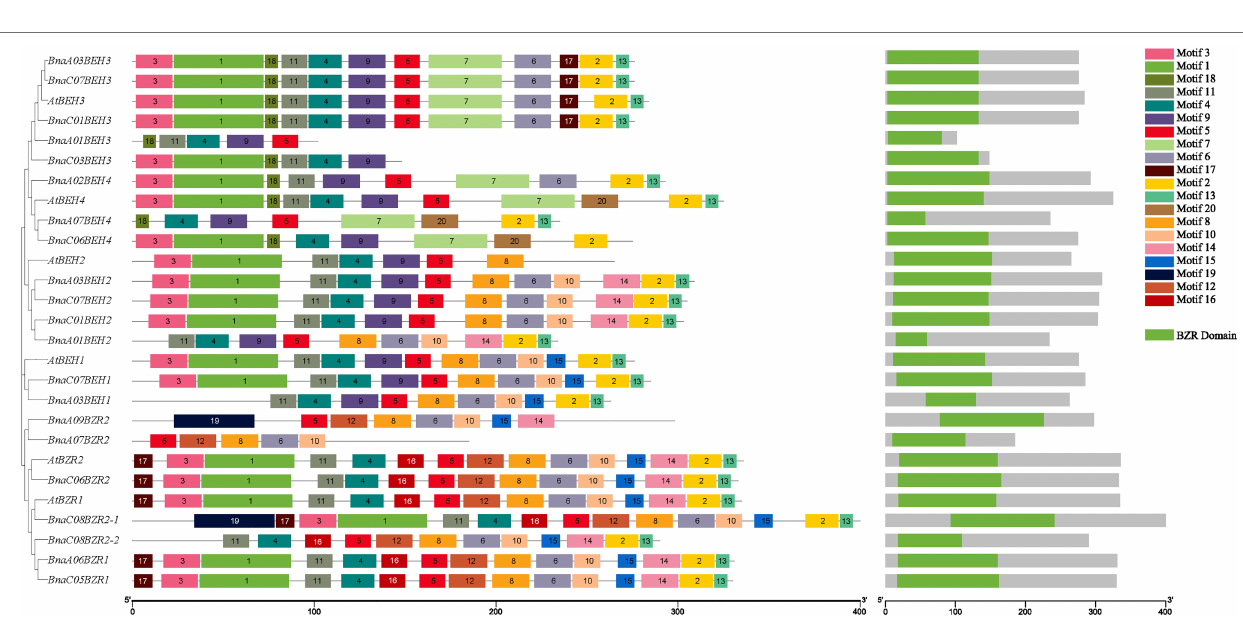
FIGURE 4 | Schematic representation of conserved motifs distribution among B. napus and A. thaliana BZR gene family. The 20 conserved motifs are indicated by different colored boxes and numbers, the logo of each motif was presented in Supplementary Figure S2 . The MEME score for the protein match to the motif model was equals to <1 × 10 − 20 . The schematic illustration of BZR domain at the N-terminal regions of the BnaBZRs was a set of